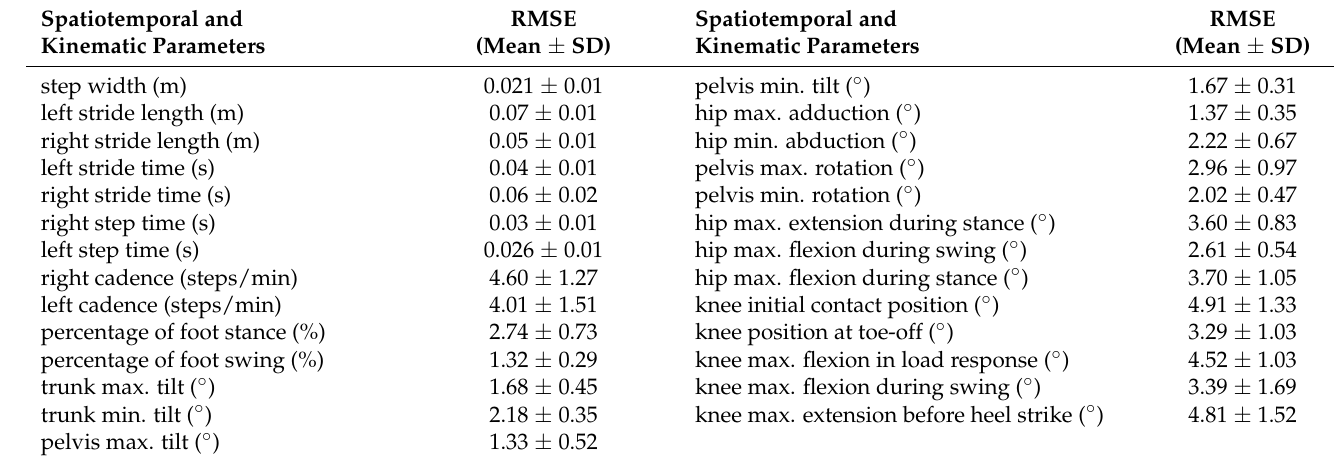
Table 3. Results of the validation of the robotic system when compared with a Vicon system. The table shows the accuracy of the system in retrieving the main gait descriptors. The values were averaged for all iterations. Spatiotemporal and RMSE Spatiotemporal and RMSE Kinematic Parameters (Mean ± SD) Kinematic Parameters (Mean ±